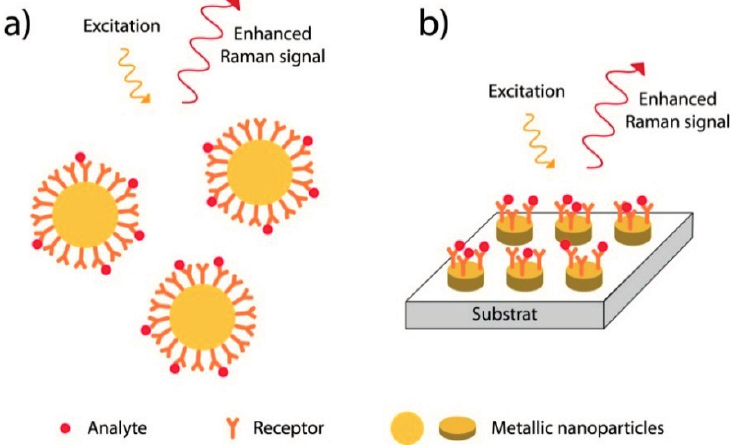
Figure 9. Principle of SERS sensors ( a ) in solution or ( b ) on